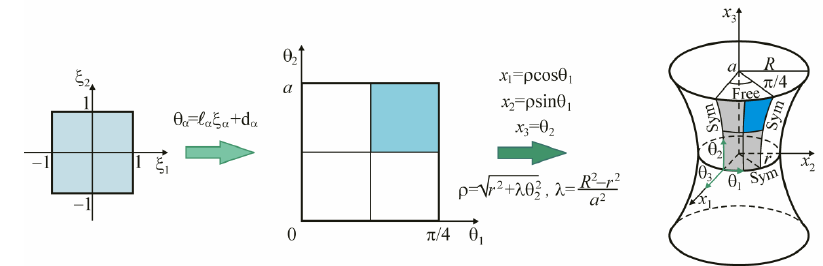
Figure 9: Through-thickness distributions of stresses for a spherical shell with seven equispaced SaS using a regular 64 × 1 mesh; exact Lamé’s solution [45] (○).